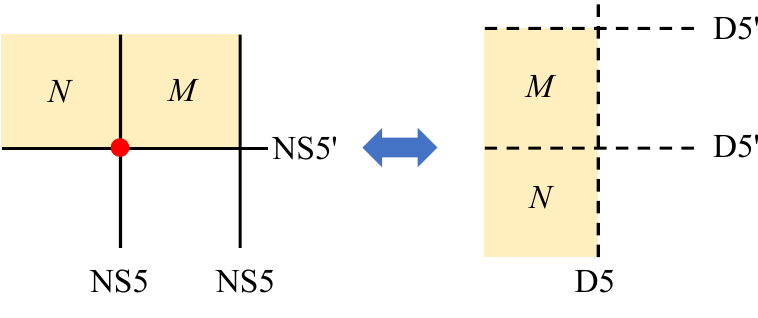
3d U( M ) with Neumann b.c. |